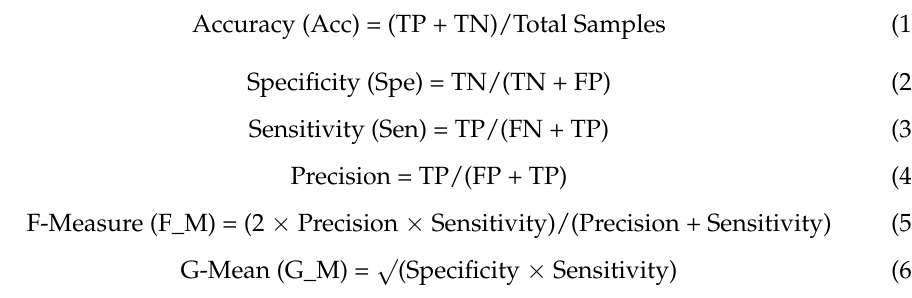
Figure 7. Location identification for chb01_03 using the proposed algorithm. Channels 1, 5, 9, and 14 show the amplitude level above the set threshold corresponding to the frontal-lobe seizure.